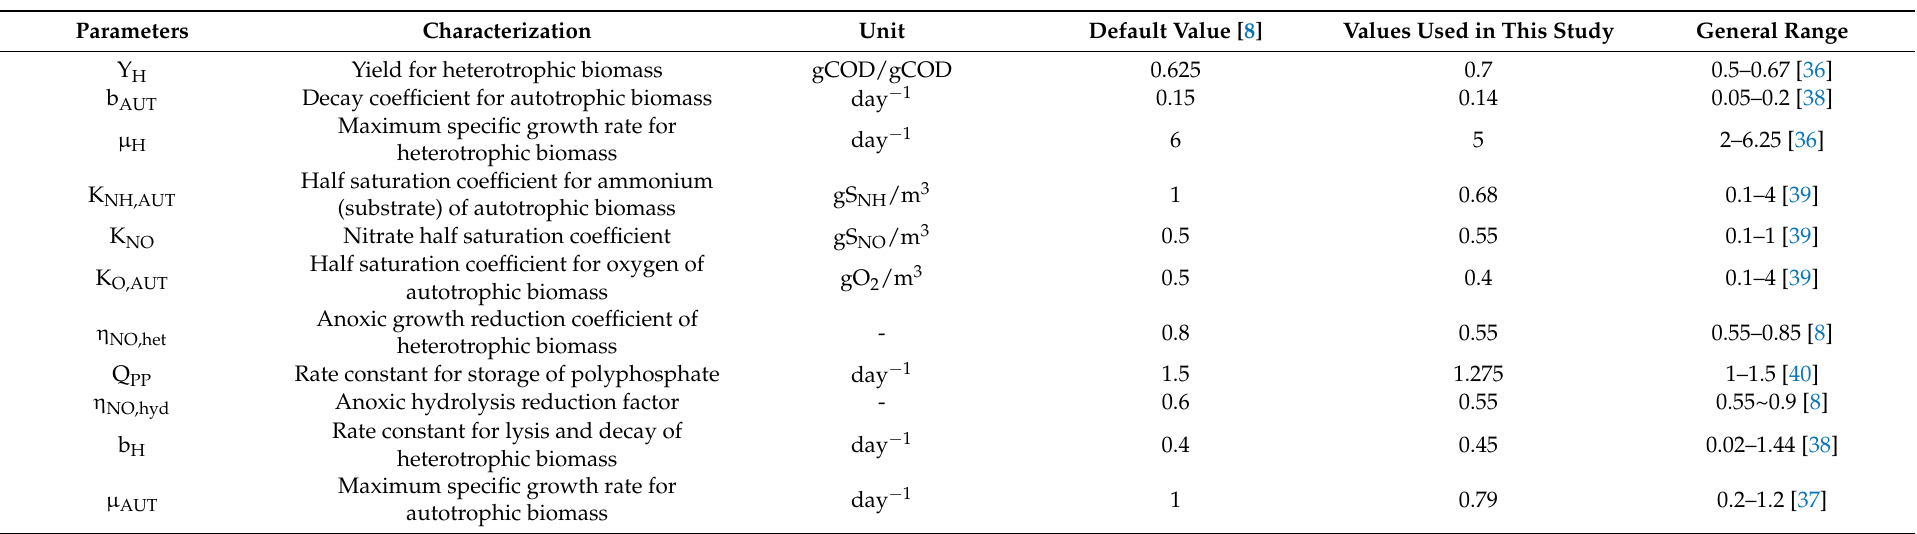
Table 2. Default and adjusted values of 11 key parameters in the ASM2d based on the lab-scale AAO